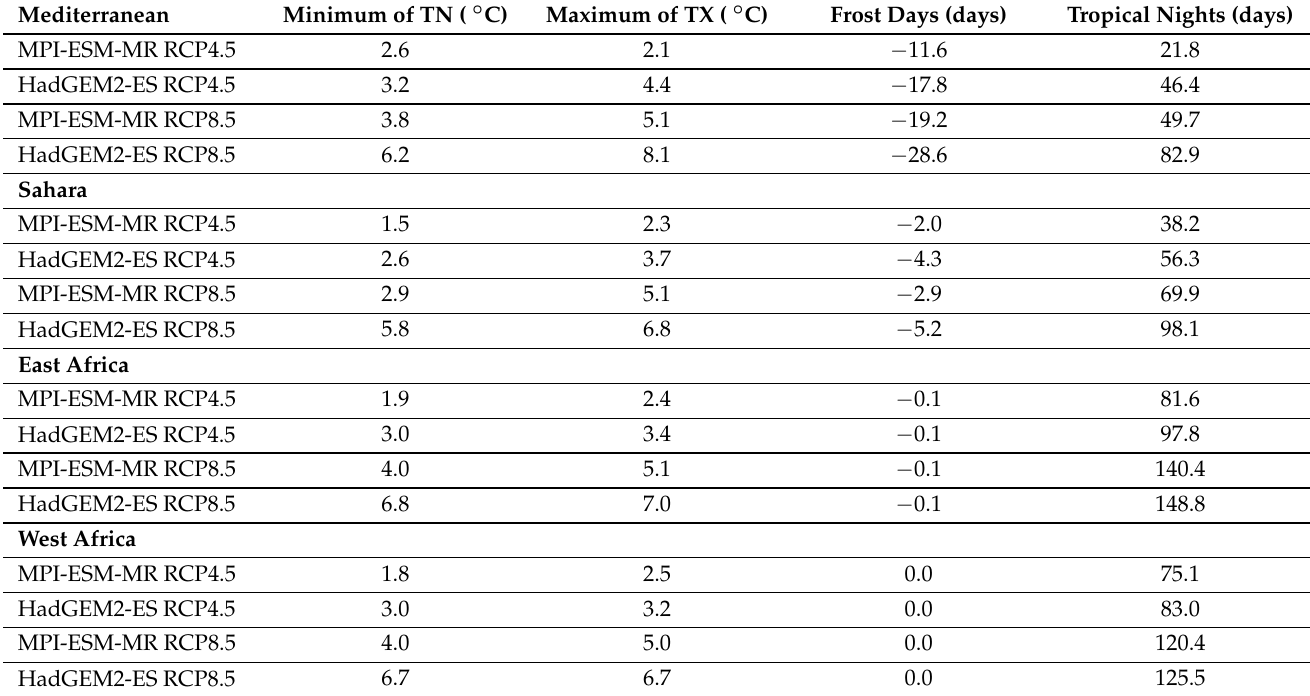
Table 2. The temporally averaged changes in absolute and threshold temperature indices weighted over sub-regions of MENA for the period of 2071–2100 displayed as differences with respect to the reference period